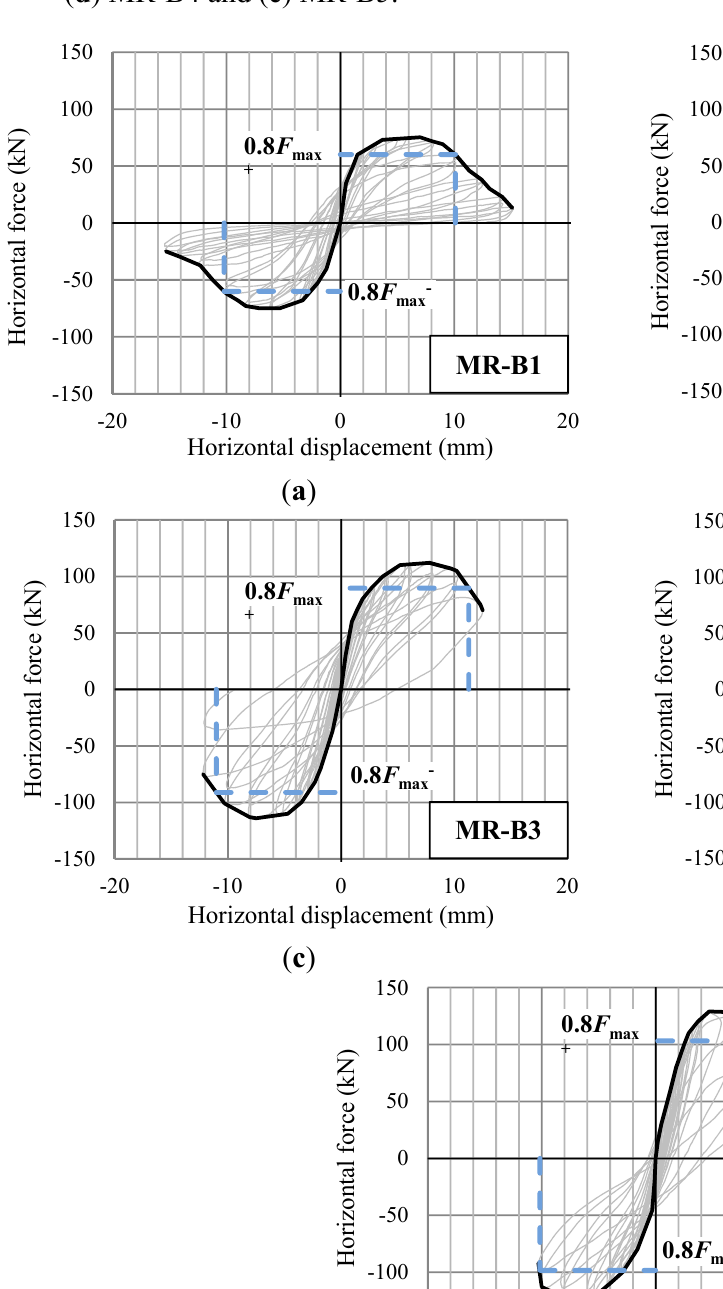
Figure 3. Load-displacement curves in Series MR-B. ( a ) MR-B1; ( b ) MR-B2; ( c ) MR-B3; ( d ) MR-B4 and ( e )